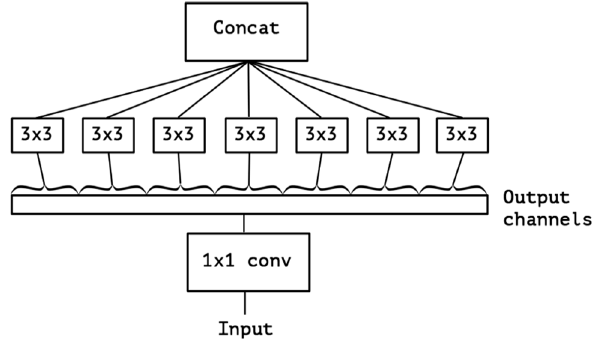
Fig. 5 Residual dimension- ing using a scaling activation, obtained from